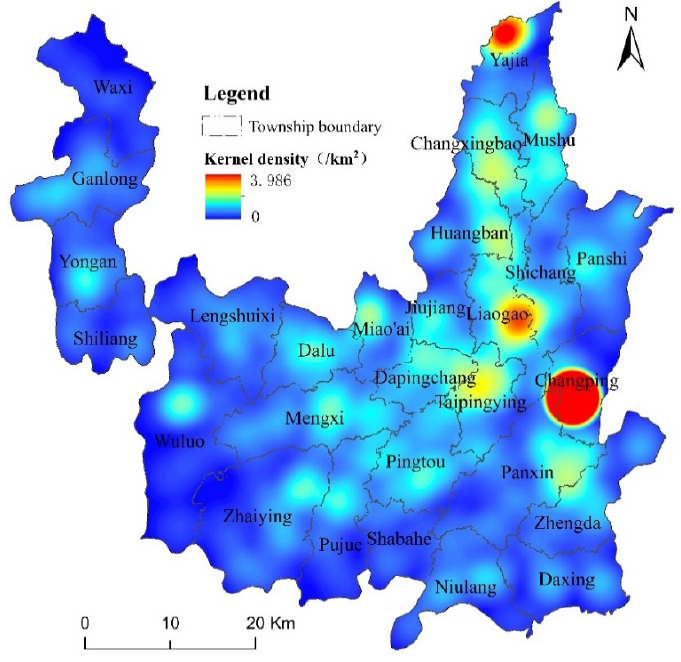
Figure 4. Rural settlements kernel density in the study area.